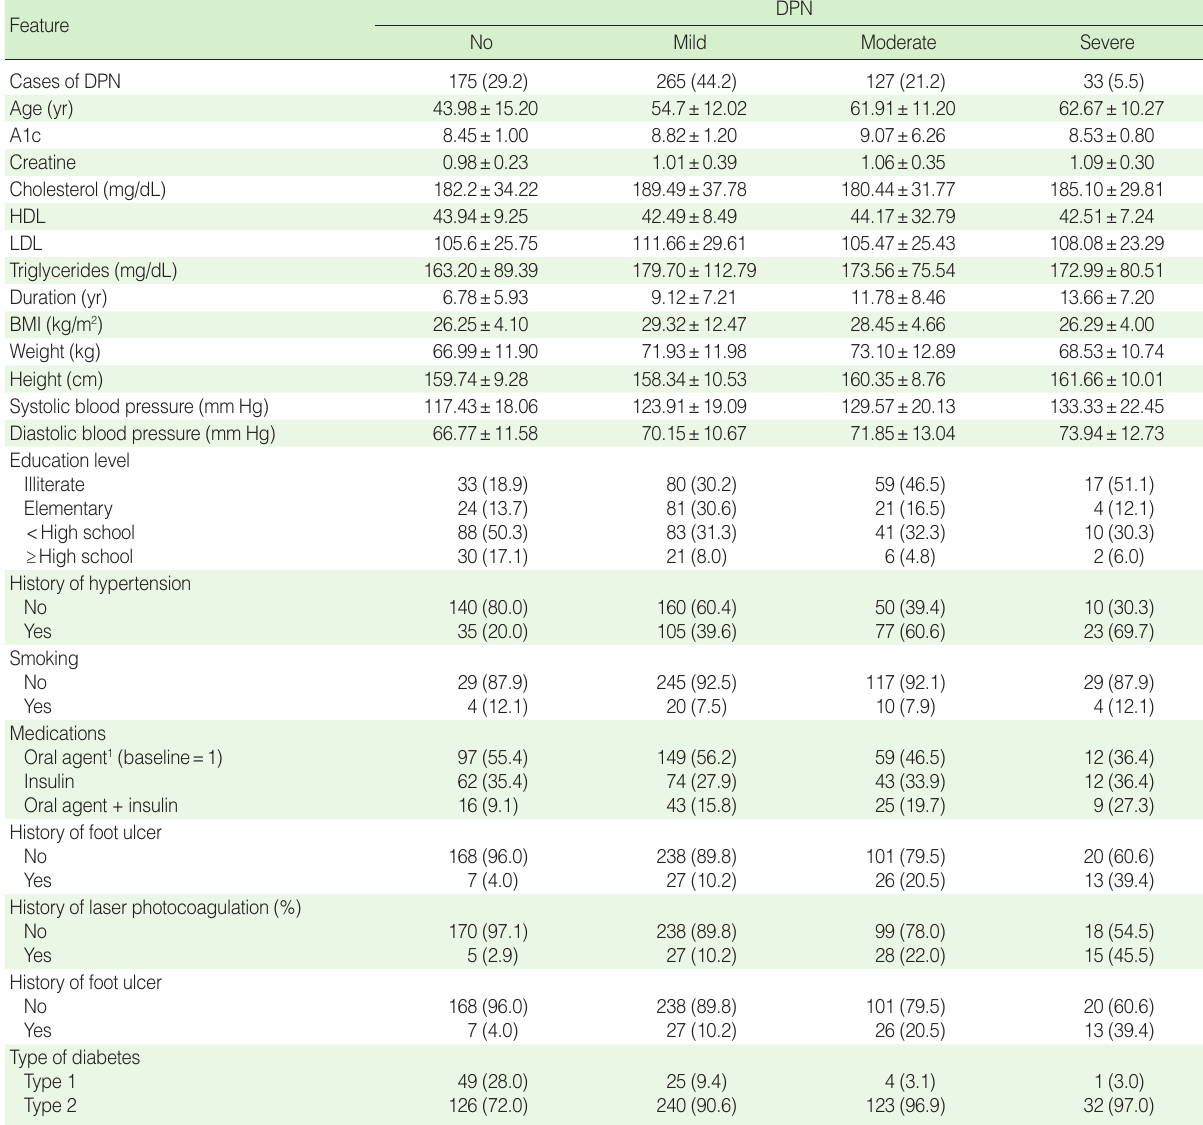
Table 1. Baseline characteristics of the study population by severity of DPN